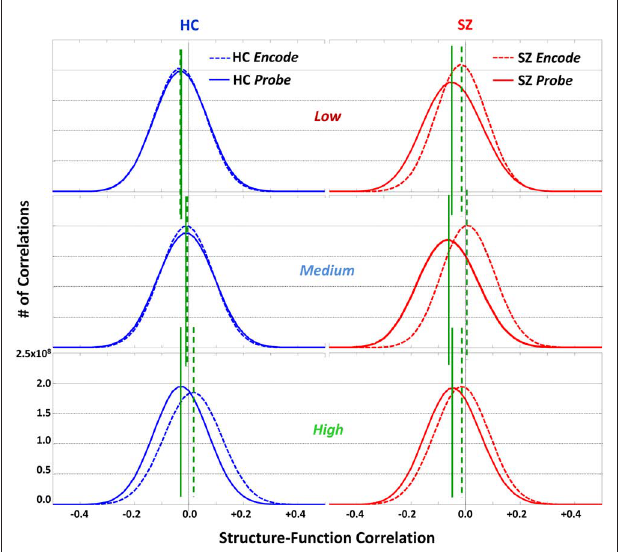
FIguRe 3 | Structure–function whole brain correlation histogram. Histogram of whole brain correlations computed between gray matter concentrations (structural) and activation coefficients (functional) for the SIRP working memory task are presented for patients with schizophrenia (SZ, in red) and healthy controls (HC, in blue). The histograms for Encode and Probe are presented with dotted and solid curves respectively. The y -axis represents the number of occurrences of correlation values given along the x -axis. In HC the histograms for Encode and Probe overlap for Low and Medium loads but separate at high load. In SZ the Encode and Probe histograms are separated at all